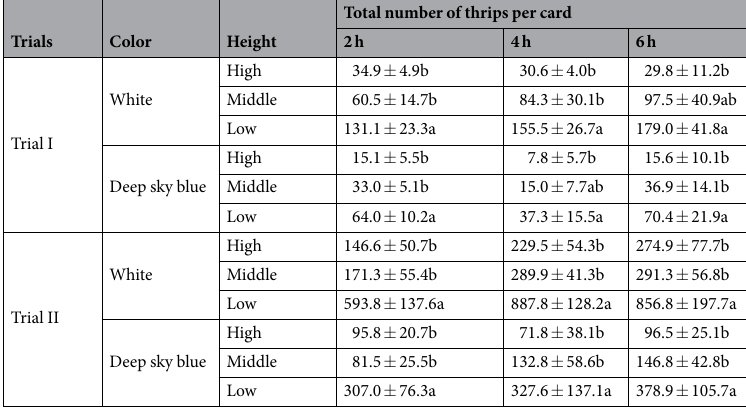
Table 1. The attractiveness of two selected colored cards with different height in trials I and II. (Values are expressed as the mean ± SEM of four replicates, with 2 cards per replicate, P < 0.05).